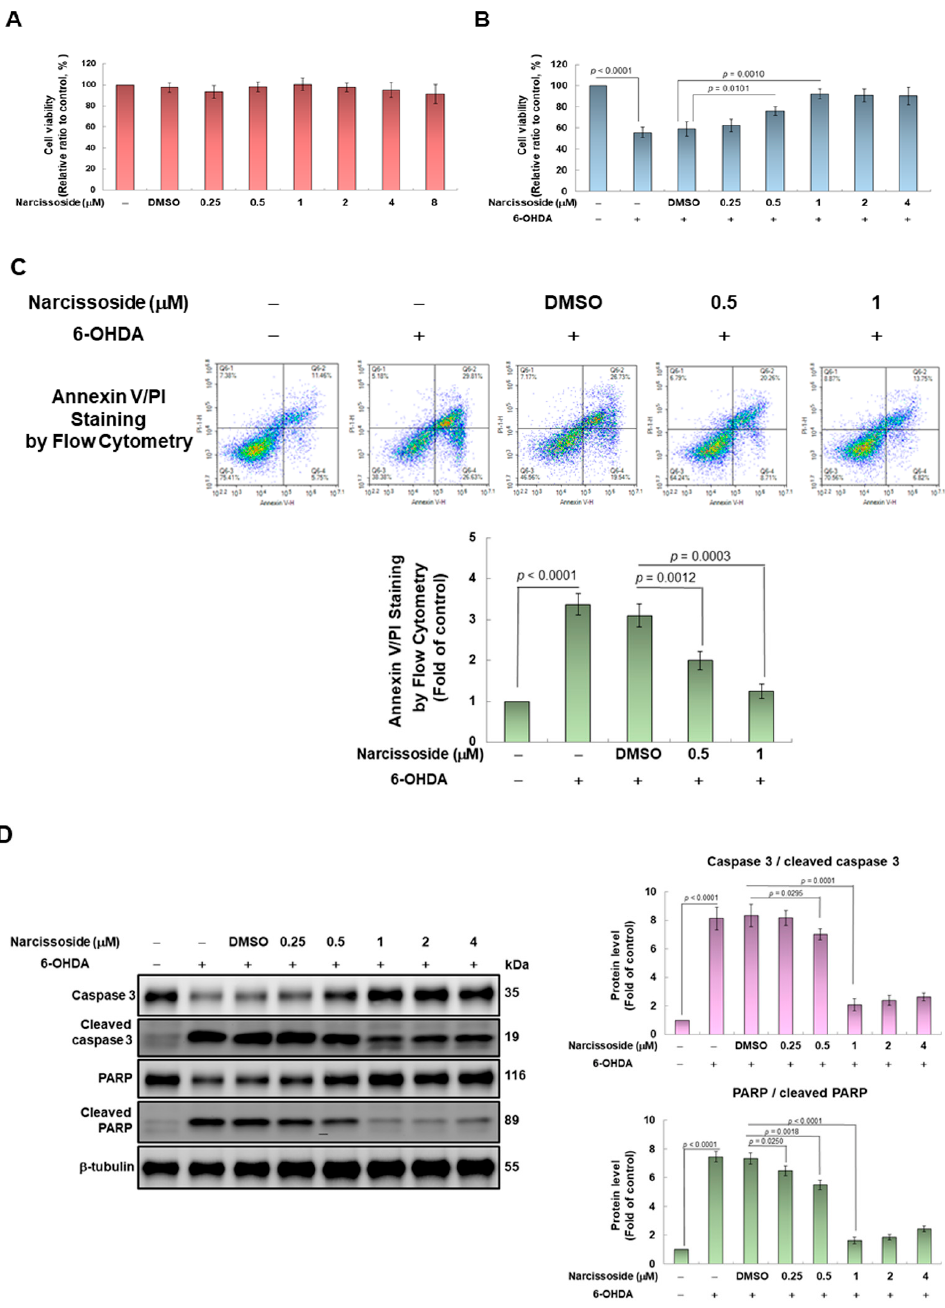
Figure 2. Pretreatment of narcissoside (NCS) attenuated apoptosis of SH-SY5Y cells induced by 6-OHDA exposure. ( A ) Cells were pretreated with the indicated concentrations of NCS for 24 h and then cell viability was measured using CellTiter Blue Cell Viability Assay. The DMSO concentration applied is 0.1%. ( B ) Experimental cells following ( A ) were treated with 100 µ M 6-OHDA for an additional 18 h. Cell viability was determined by CellTiter Blue Cell Viability Assay. ( C ) The ratio of cell apoptosis was analyzed using annexin V-FITC binding and propidium iodide (PI) uptake. FITC and PI fluorescence was measured by flow cytometry. (Top). Q1 is a dead cell, Q2 is a late apoptotic cell, Q3 is a live cell, and Q4 is an early apoptotic cell. The apoptosis rate was quantified by (Q2 + Q4)/(Q1 + Q2 + Q3 + Q4) × 100% (bottom) ( D ) The ratio of cleaved caspase 3/pro caspase 3 and cleaved PARP/pro PARP was determined by western blotting and β -tubulin was internal control (left). The intensity of the signal was quantified by the ImageJ software.